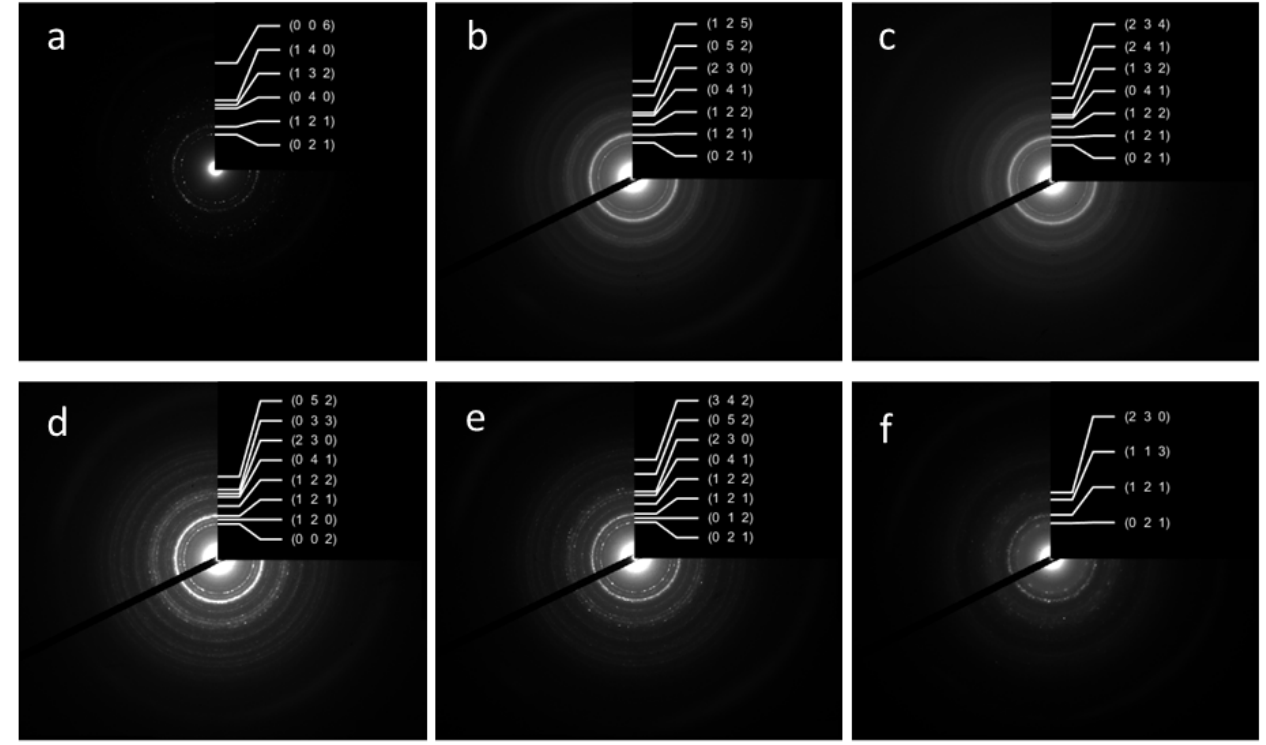
Figure 2. SAED ring patterns and Miller indexes of the powder samples W-1 ( a ), WA-1 ( b ), WE-1 ( c ), W-21 ( d ), WA-21 ( e ), WE-21 ( f ).